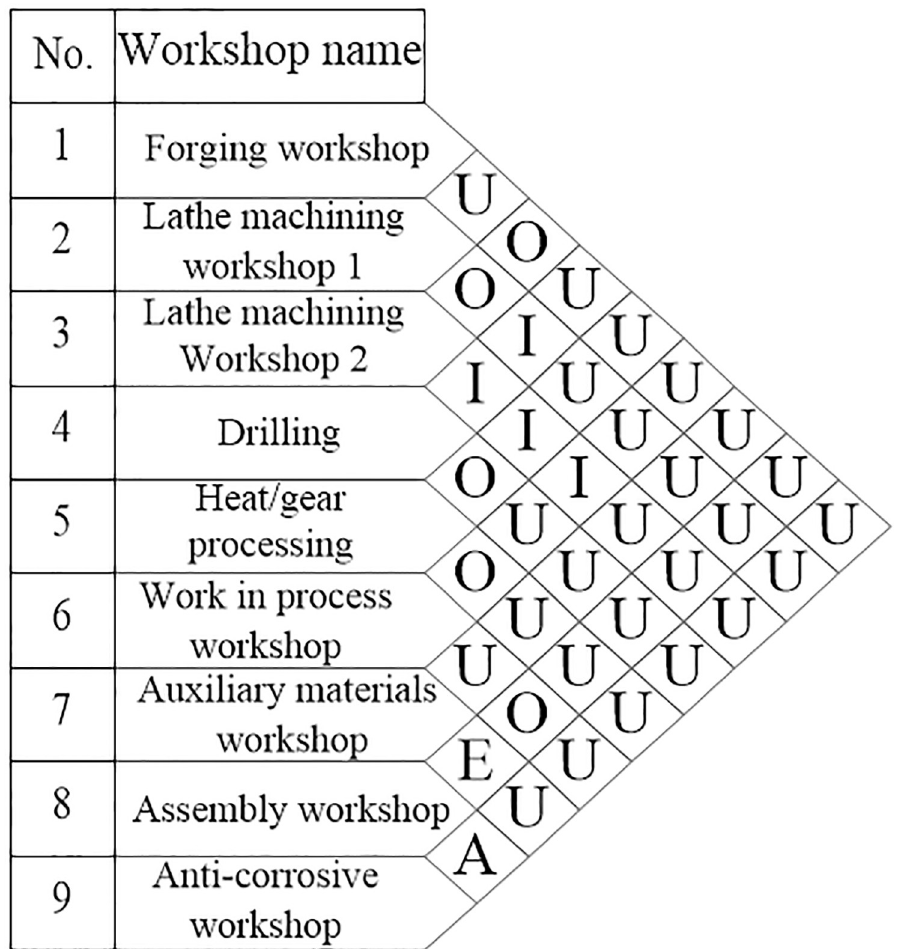
Fig 7. Production unit correlation